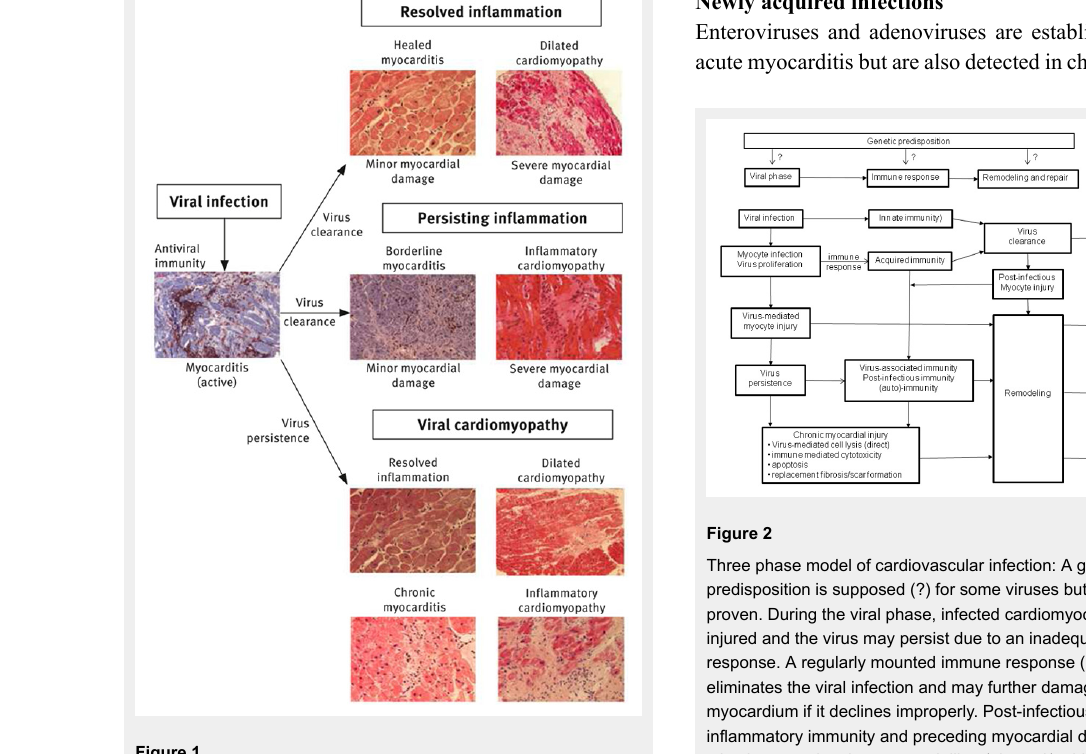
Histological, immunohistochemical and molecular biological findings at distinct phases of viral myocarditis.